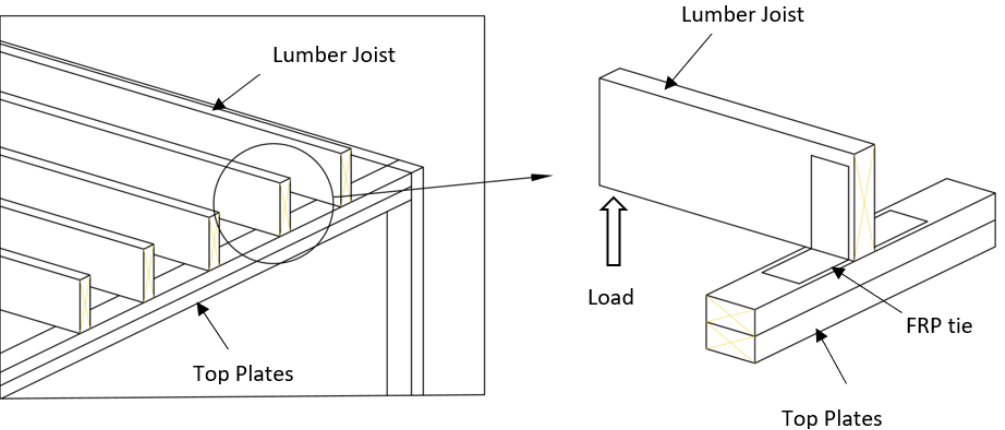
Figure 1. Schematic of wood roof-to-wall connection.